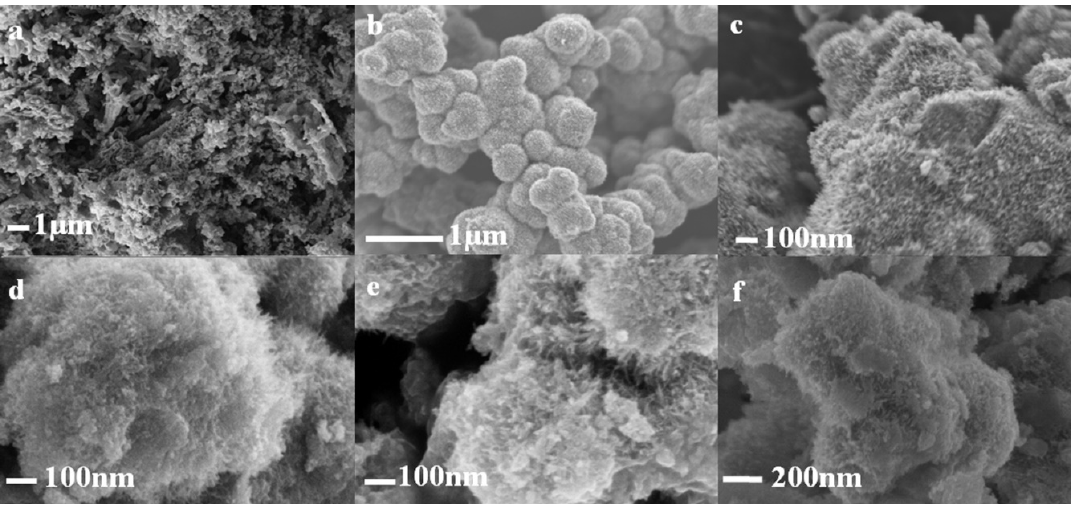
Figure 6. SEM images of ( a ) GCN, ( b ) NBO, ( c ) NBCN‐1, ( d ) NBCN‐2, ( e ) NBCN‐3, and ( f ) NBCN‐4.